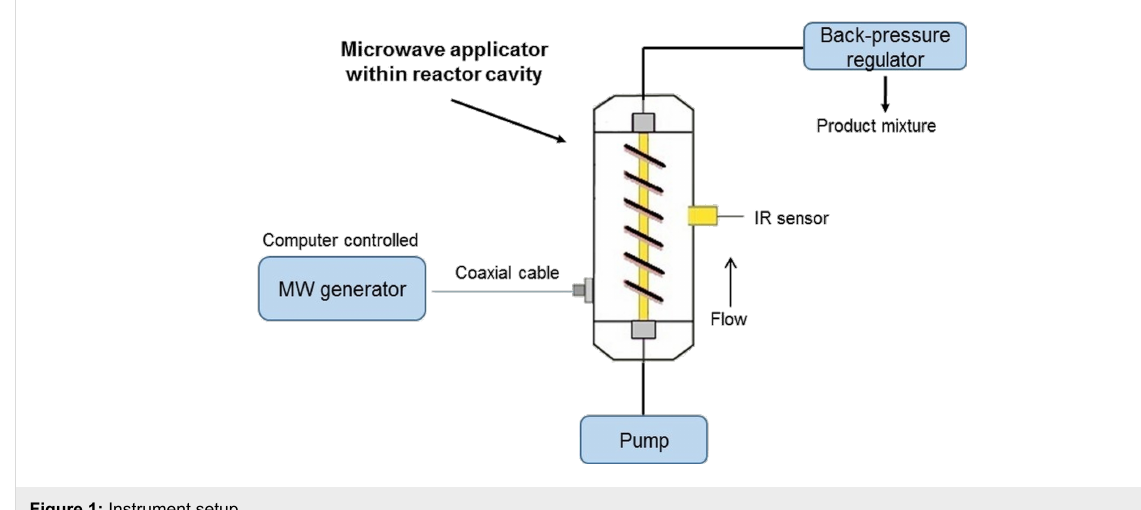
Figure 1: Instrument setup.